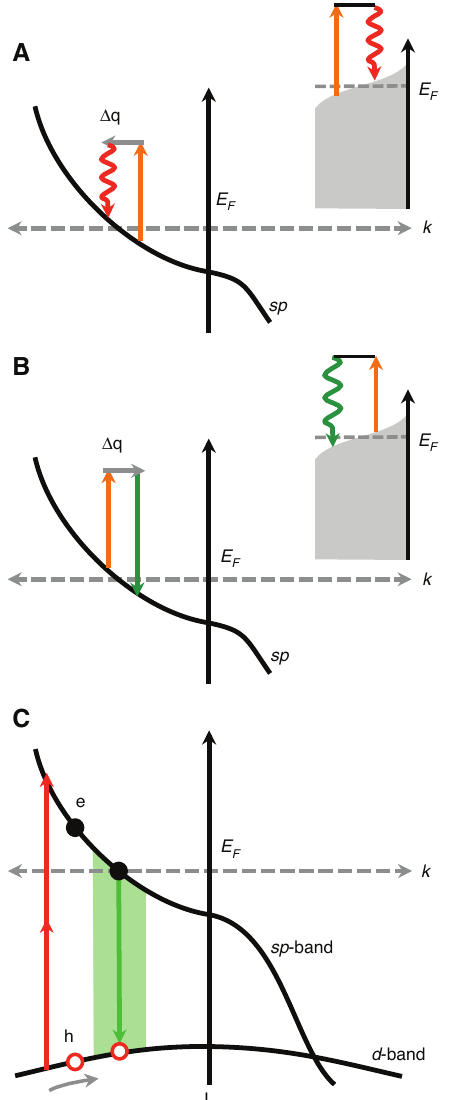
Figure 5: The incoherent radiation from the metal at frequencies shifted from the incident frequency, shown here for gold near the L symmetry point in the Brillouin